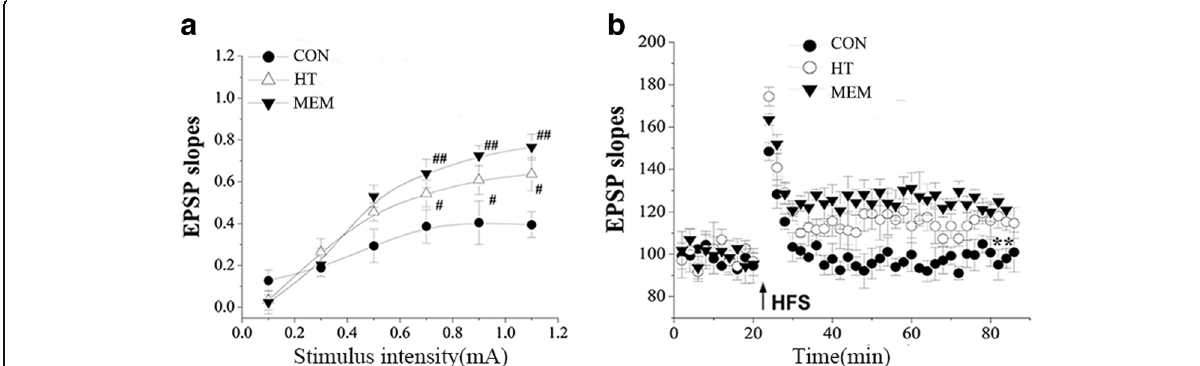
Fig. 4 HT improves synaptic function in APP/PS1 Transgenic Mice. Electrophysiological determination of deficits in Schaffer collateral-CA1 synaptic transmission and the induction of long-term potentiation. a A plot showing input/output (I/O) curves in response to stimulus (0.1 – 1.1 mA) at the hippocampal CA1 region of APP/PS1 control mice, APP/PS1 mice receiving HT, and APP/PS1 mice receiving MEM treatment (6 months old). The I/O curve was measured by averaging the slope of EPSPs against stimulus intensity at 0.1 – 1.1 mA. The slope of the regression line for the I/O curve in APP/PS1 mice was markedly reduced. With HT or MEM treatment, the reduction in the I/O curve slope was significantly improved in APP/PS1 mice. All values are expressed as the mean±SEM from 6 mice in each group. # P <0.05 HT group versus APP/PS1 control mice, ## P <0.01 MEM group versus APP/PS1 control mice. b The capacity to establish long-term potentiation (LTP) from high-frequency stimulus (HFS, 100 pulses at 100 Hz) with the same pre-HFS intensity at hippocampal CA1 region of APP/PS1 control mice. APP/PS1 mice with HT treatment and APP/PS1 mice with MEM